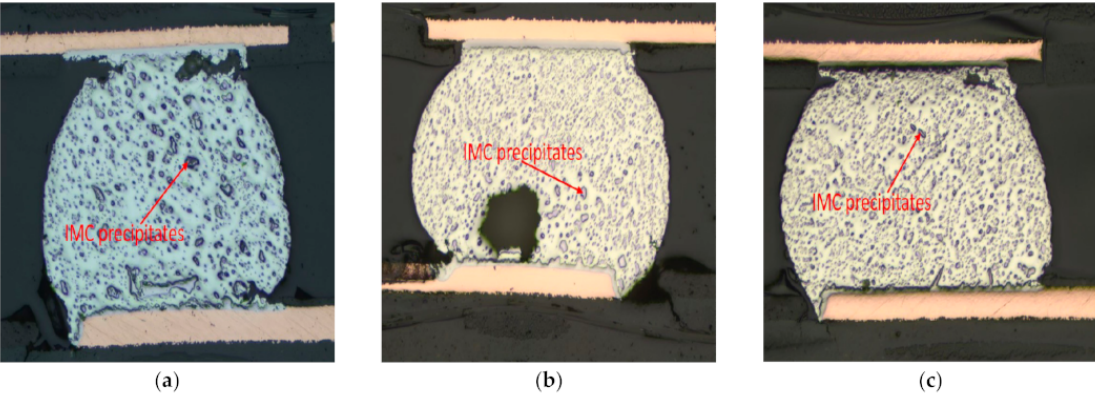
Figure 16. Cross-section images of different alloys; ( a ) SAC-In; ( b ) SAC-Bi; and ( c ) Innolot